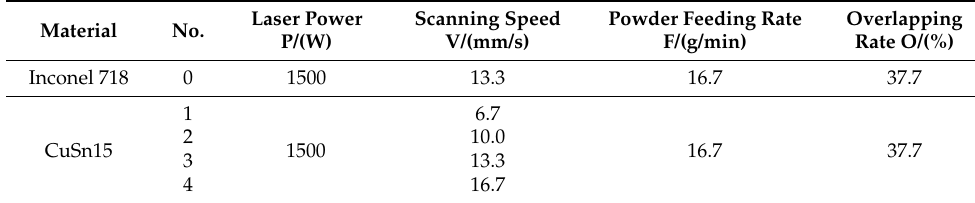
Table 2. Parameters for the LDED process.